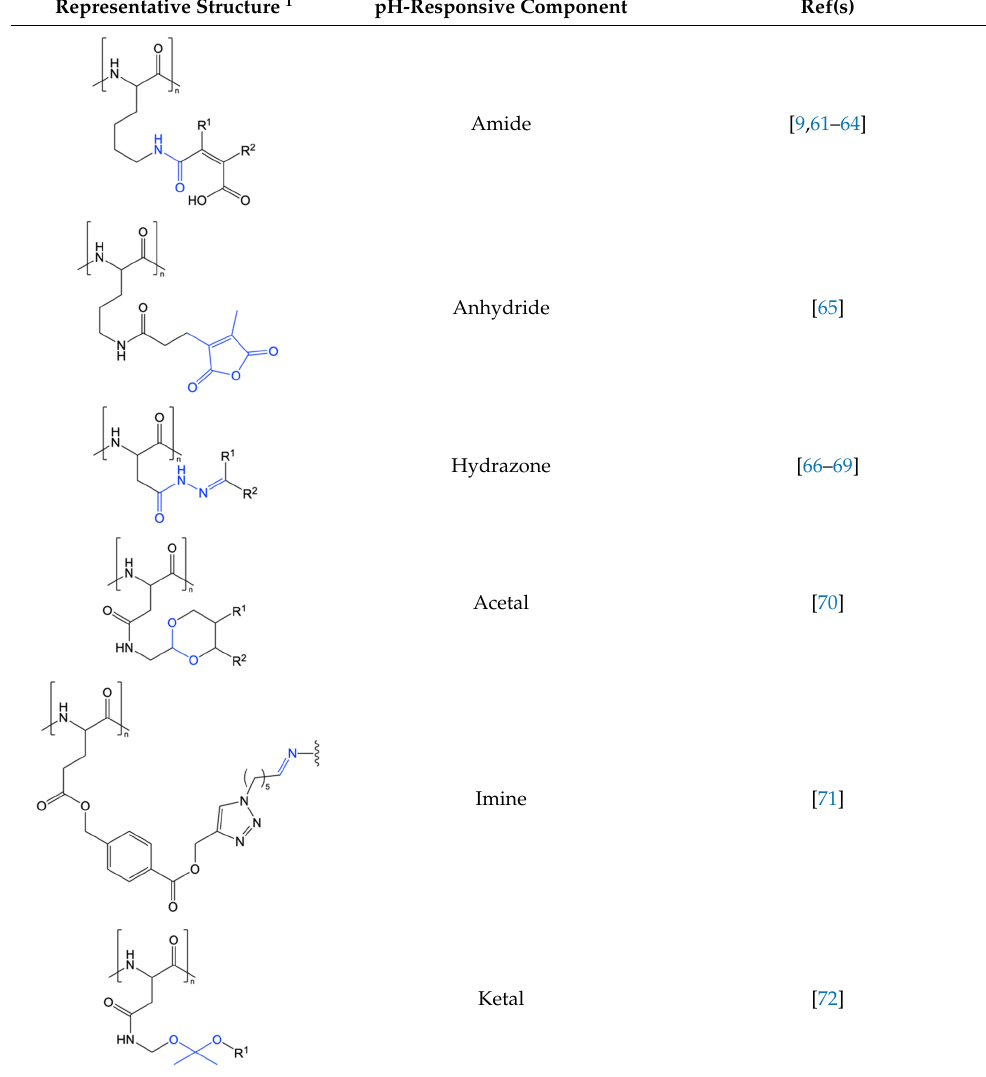
Table 1. Summary of key pH-labile linkages for the development of cleavable functionalities.